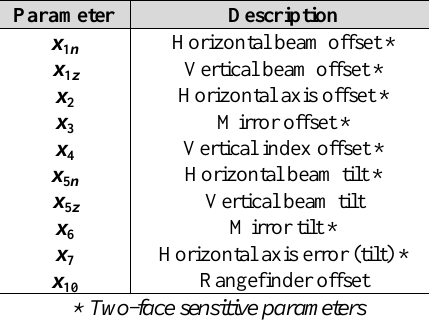
Table 1. List of the TLS misalignments relevant for the high- end panoramic